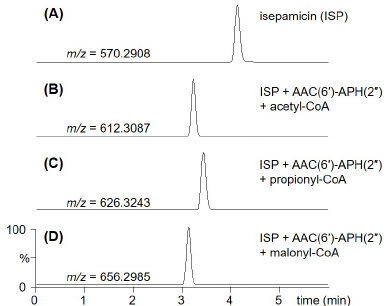
Figure 2. UPLC-qTOF-HR-MS analysis of the ISP and its analogs produced by the enzymatic synthesis using AAC(6 (cid:48) )-APH(2”). ( A ) UPLC-qTOF-HR-MS chromatogram of ISP (selected m / z